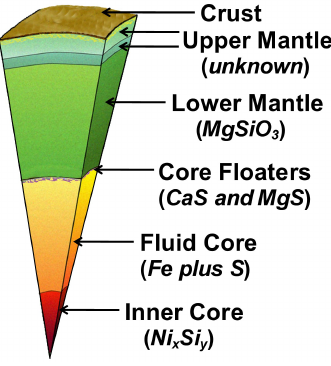
Figure 5. Chemical compositions of the major parts of the endo- Earth. From Herndon